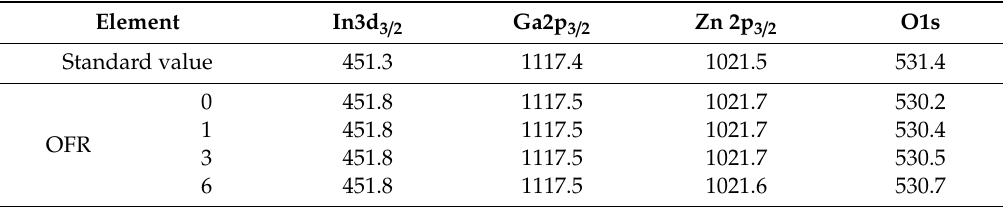
Table 1. The binding energy values at peak intensity of In 3d 3/2 , Ga 2p 3/2 , Zn 2p 3/2 , and O 1s electronic state with different oxygen flow rate (OFR), along with the corresponding standard values. Element In3d 3 /